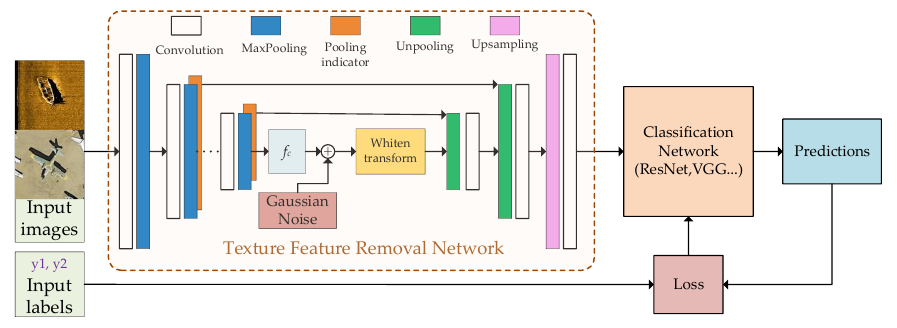
Figure 12. Network structure of our method.